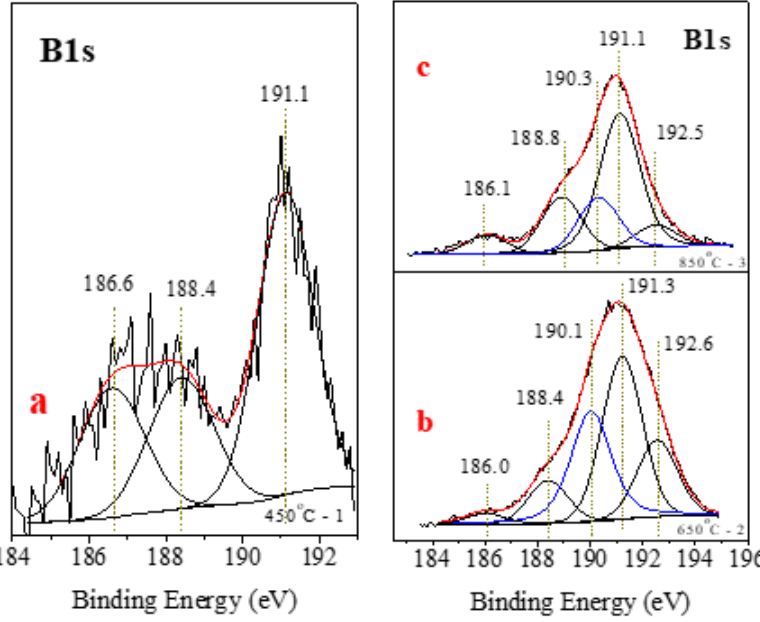
Figure 9. ( a – c ). XPS spectra of the B1s core level for the annealed samples. For sample 3, the area of the corresponding BN phase at 190.3 eV is 18% of the area of the whole spectrum. Table 3 summarizes the percentages of the boron phases. Table 3. Percentage of boron phases in each